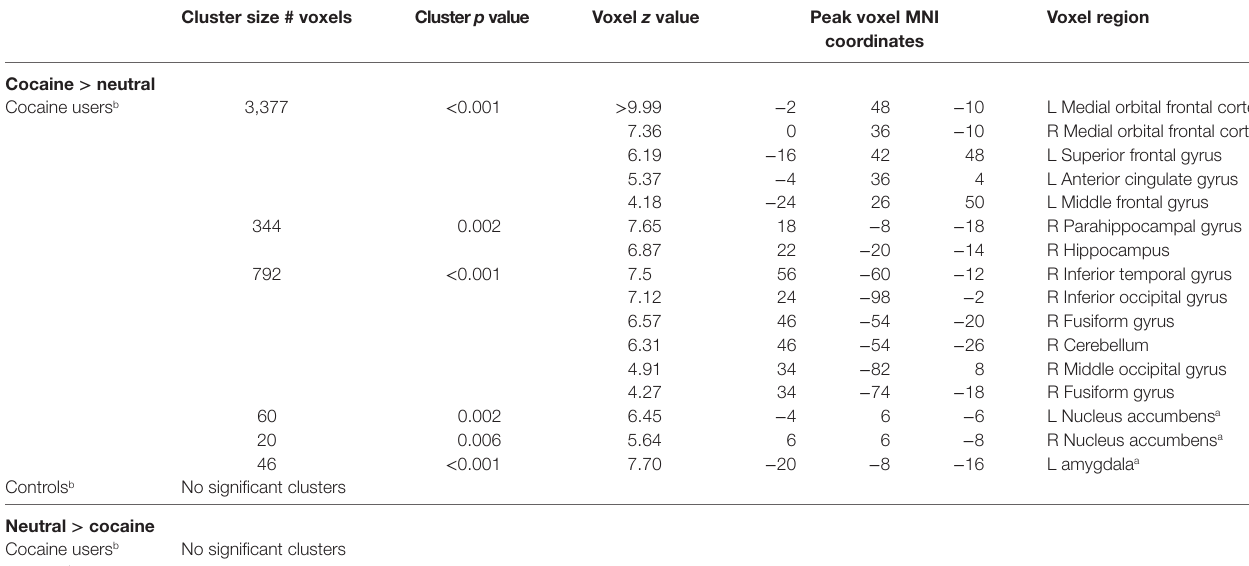
TaBle 2 | Cue reactivity group by stimulus type interaction